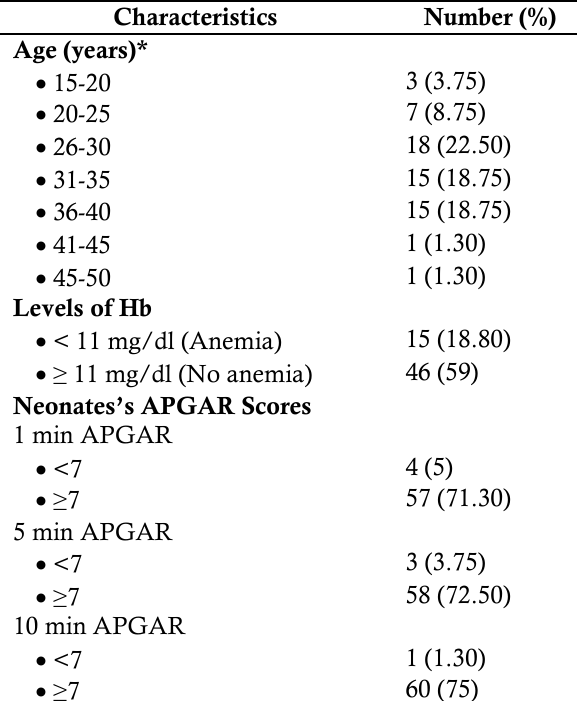
Table 1. Frequency distribution of respondent characteristics